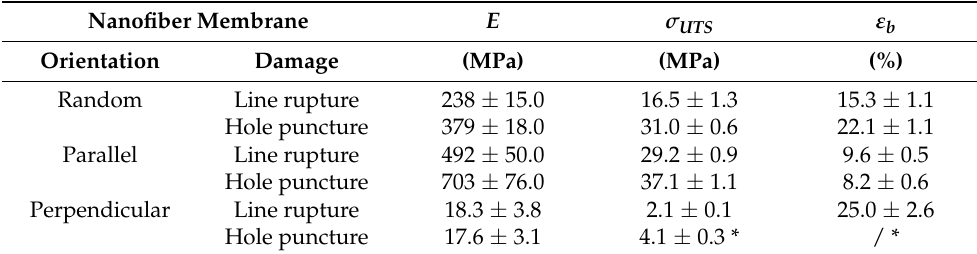
Table 2. Ultimate tensile strength for pristine and damaged nanofiber membranes. Nanofiber Membrane E σ UTS ε b Orientation Damage (MPa) (MPa) (%) Random